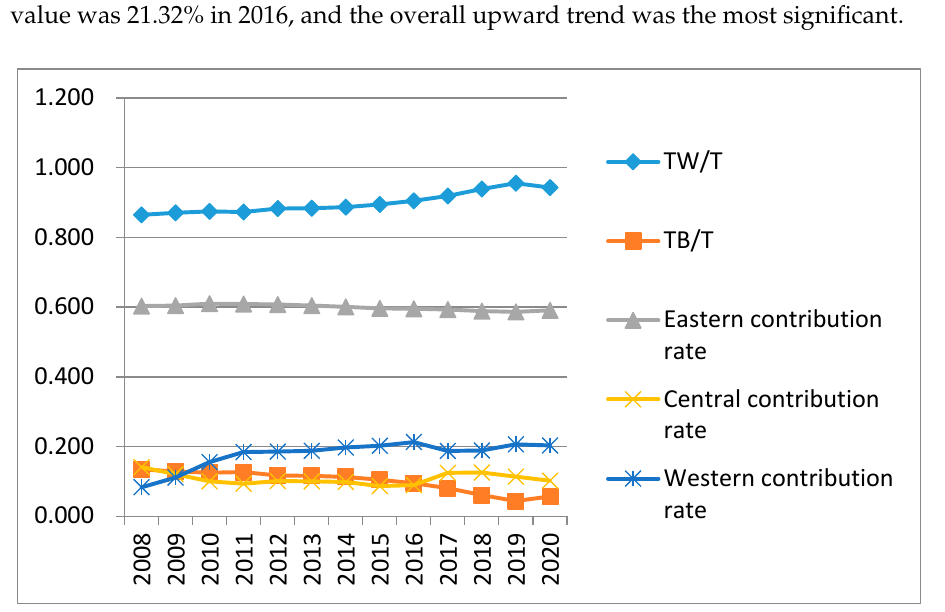
Figure 4. Trends of sources of regional differences in transportation CEE. Table 6. Source results of regional differences in transportation